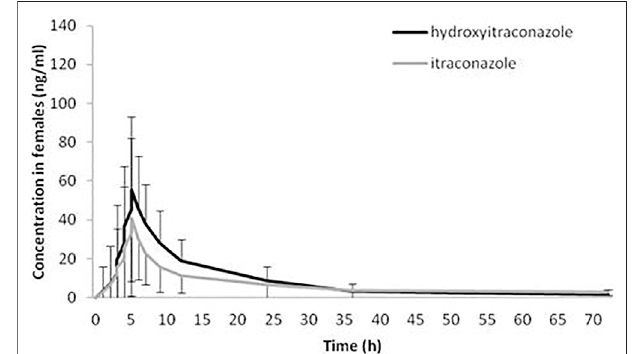
FIGURE 2 | Plasma concentration-time curves. Geometric mean and standard deviation of hydroxy-itraconazole plasma concentrations over time after a single oral dose of 100 mg of itraconazole in 114 analyzed sets of plasma concentrations, 66 obtained from male and 48 from female healthy Caucasian subjects.